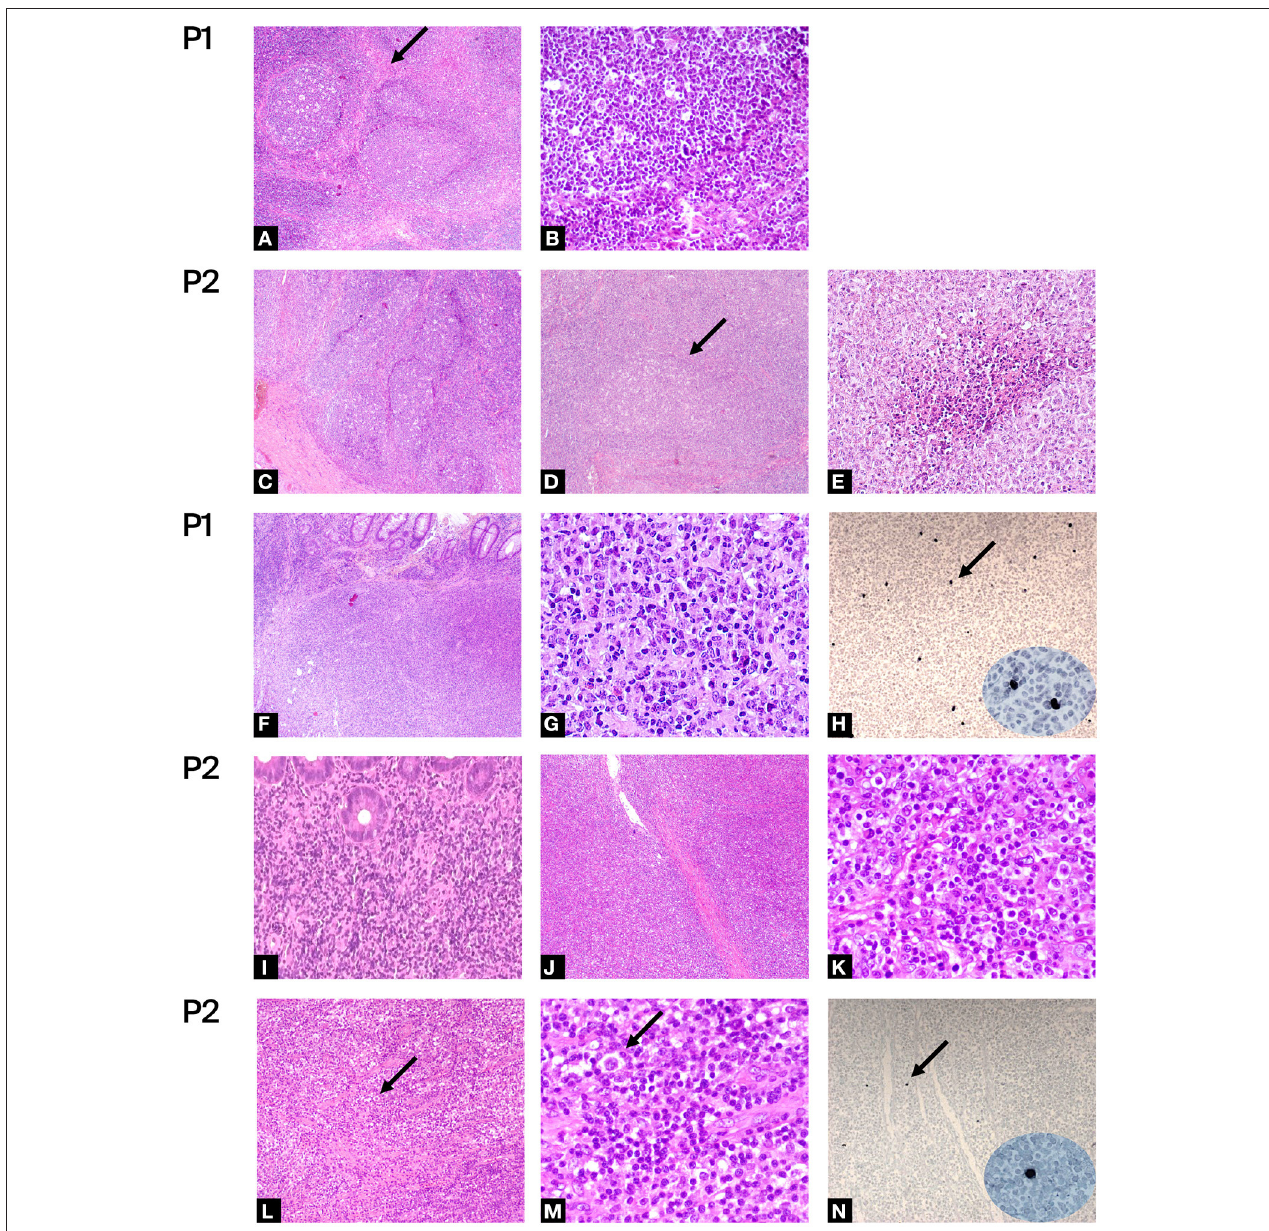
FIGURE 2 | Histologic evaluations: (A–E) Hematoxylin-eosin of benign lymph node biopsy of P1 and P2. Figures at low magnification shows: (A,C,D) large and irregularly expanded “naked” GC with ill-defined outlines, loss of the mantel zone and polarization, monocytoid B-cell hyperplasia, numerous large histocyte and tingible bodies ( A,C :4 × , D : 5 × ); (A) the arrow shows area of sclerosis around the follicle. Figures at higher magnification shows: (B) absence of mantel zone surrounding the germinal center (40 × ); (E) foci of necrosis (20 × ). (F–N) Hematoxylin-eosin of malignant biopsy of P1 and P2. (F,G,I) infiltration by polymorphous DLBCL of large bowel ( F :4 × , I :20 × , G : 40 × ) and (J,K) of lympho-node ( J : 4 × , K :40 × ). (L,M) low (10 × ) and high (40 × ) magnification of lympho-node of P2 infiltered by NLPHL. Arrows show “popcorn” cells with multilobate nucleus and scant cytoplasm surrounded by rosetting activate small lymphocytes. (H, N) In-situ hybridization for EBER, arrow shows some positive cells ( × 10, in ellipse high magnification × 40).